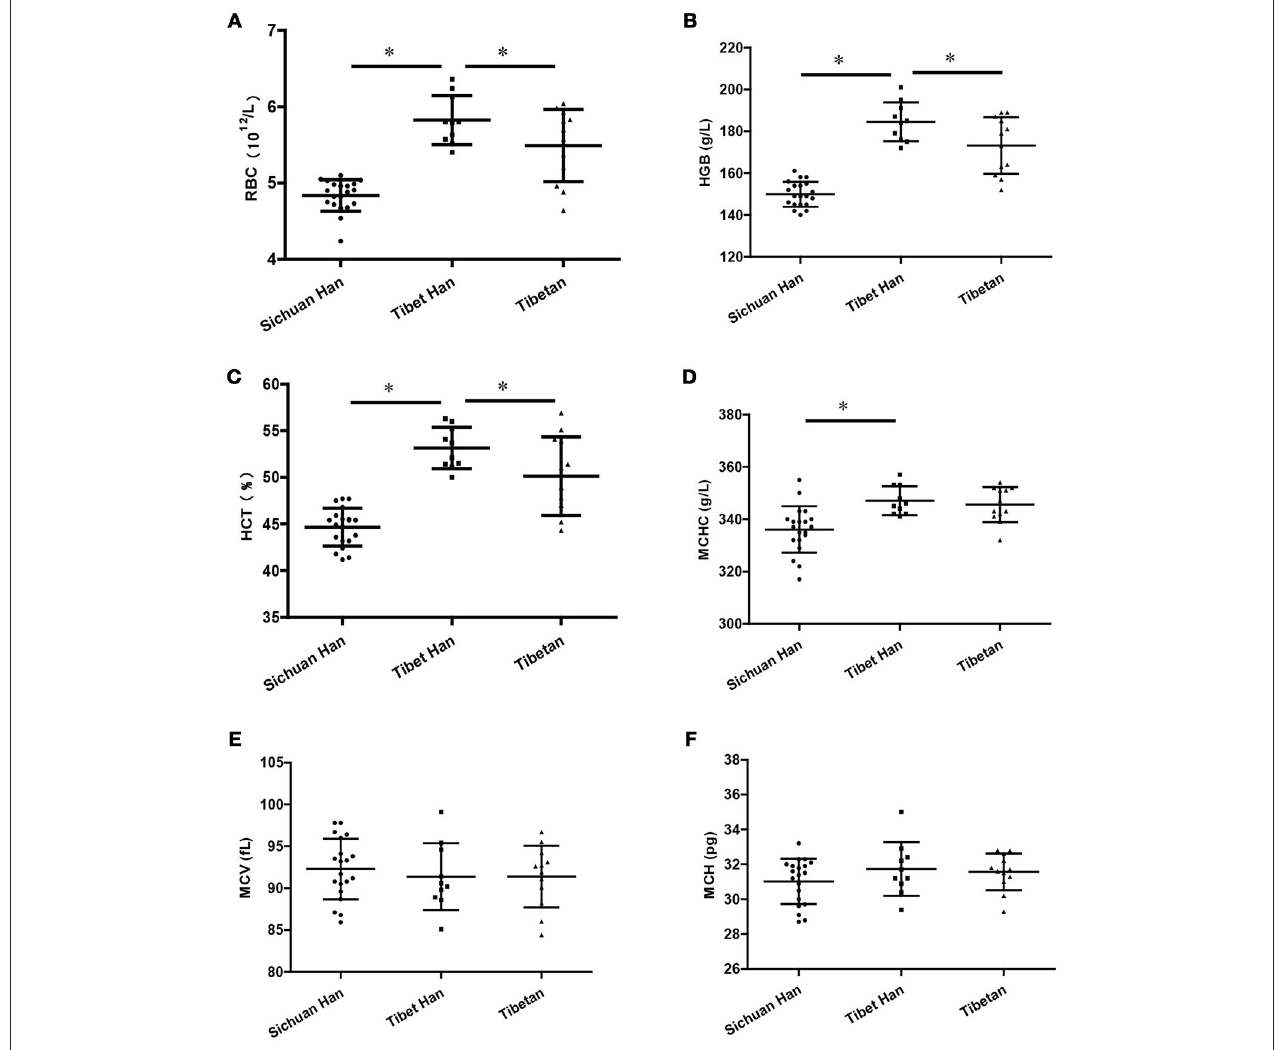
FIGURE 1 | Hematological features of the Sichuan Han, Tibet Han and Tibetan groups. RBC, red blood cell counts (A) ; HGB, hemoglobin (B) ; HCT, hematocrit (C) ; MCHC, mean corpuscular hemoglobin concentration (D) ; MCV, mean corpuscular volume (E) ; MCH, mean corpuscular hemoglobin (F) (* p -value < 0.05; error bars indicate the